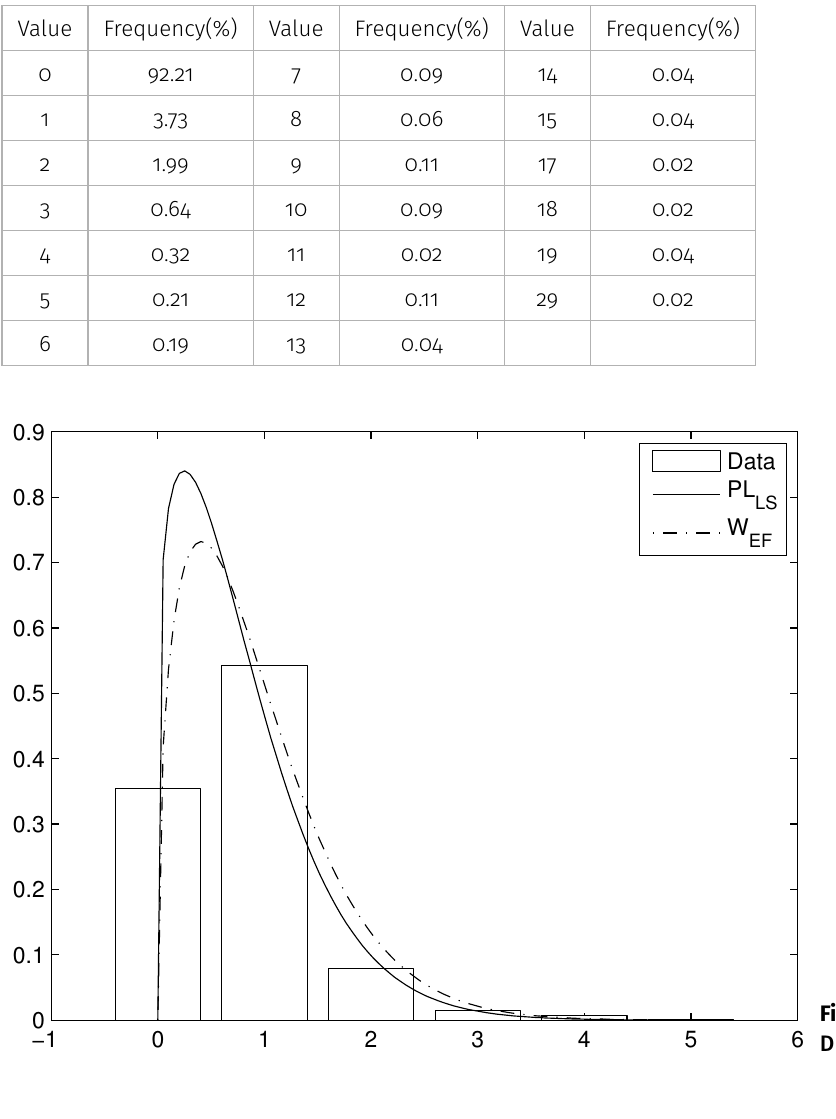
Figure 1. Fitted distributions for DIT-system